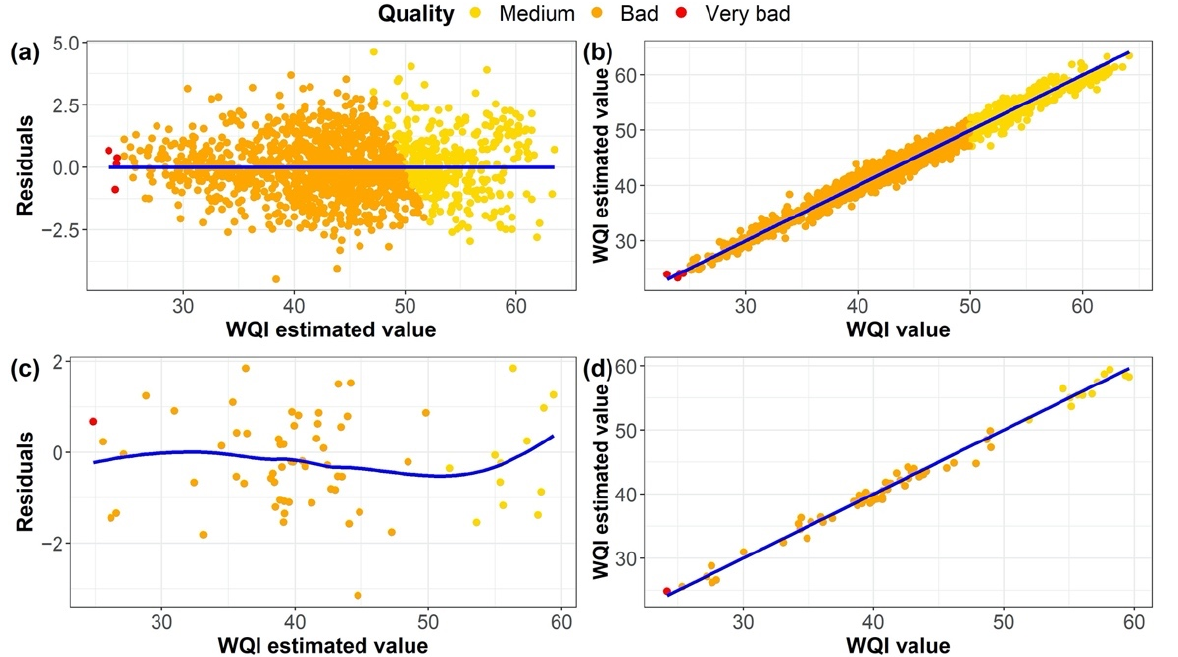
Figure 11. Generalized additive models: ( a ) Plot of residuals versus the predicted values (using the training data subset). ( b ) Real WQI values versus predicted WQI values using the training data subset. ( c ) Plot of residuals versus predicted WQI values (using the testing data subset). ( d ) Real WQI values versus predicted WQI values (using the testing data subset).